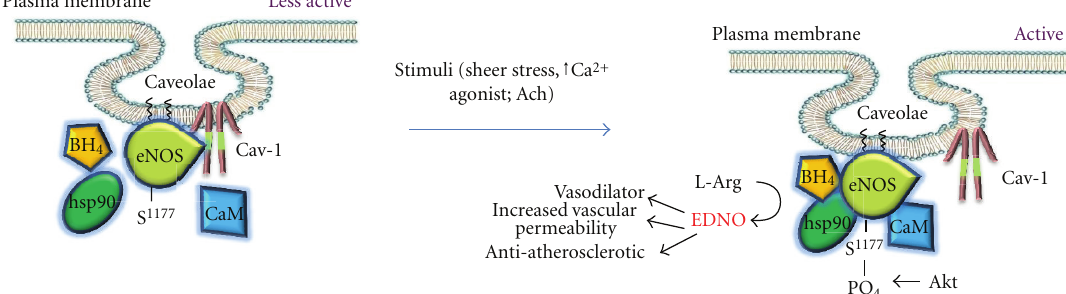
Figure 1: Under basal conditions, eNOS is kept in a “less active” state by binding to Cav-1. Activation of eNOS occurs by stimuli, (sheer stress, agonists such as acetylcholine, Ach), which causes an increase in intracellular Ca 2+ and subsequent recruitment of cofactors and phosphorylation of the enzyme at S 1177 . Following which, eNOS is dissociated from Cav-1 and e ffi cient EDNO production occurs. CaM: calmodulin; hsp90: heat shock protein